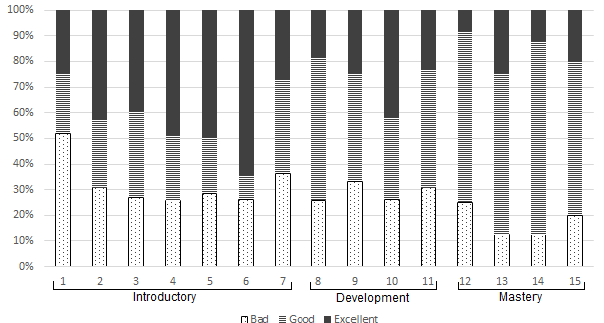
Figure 7. Distribution of the students’ knowledge